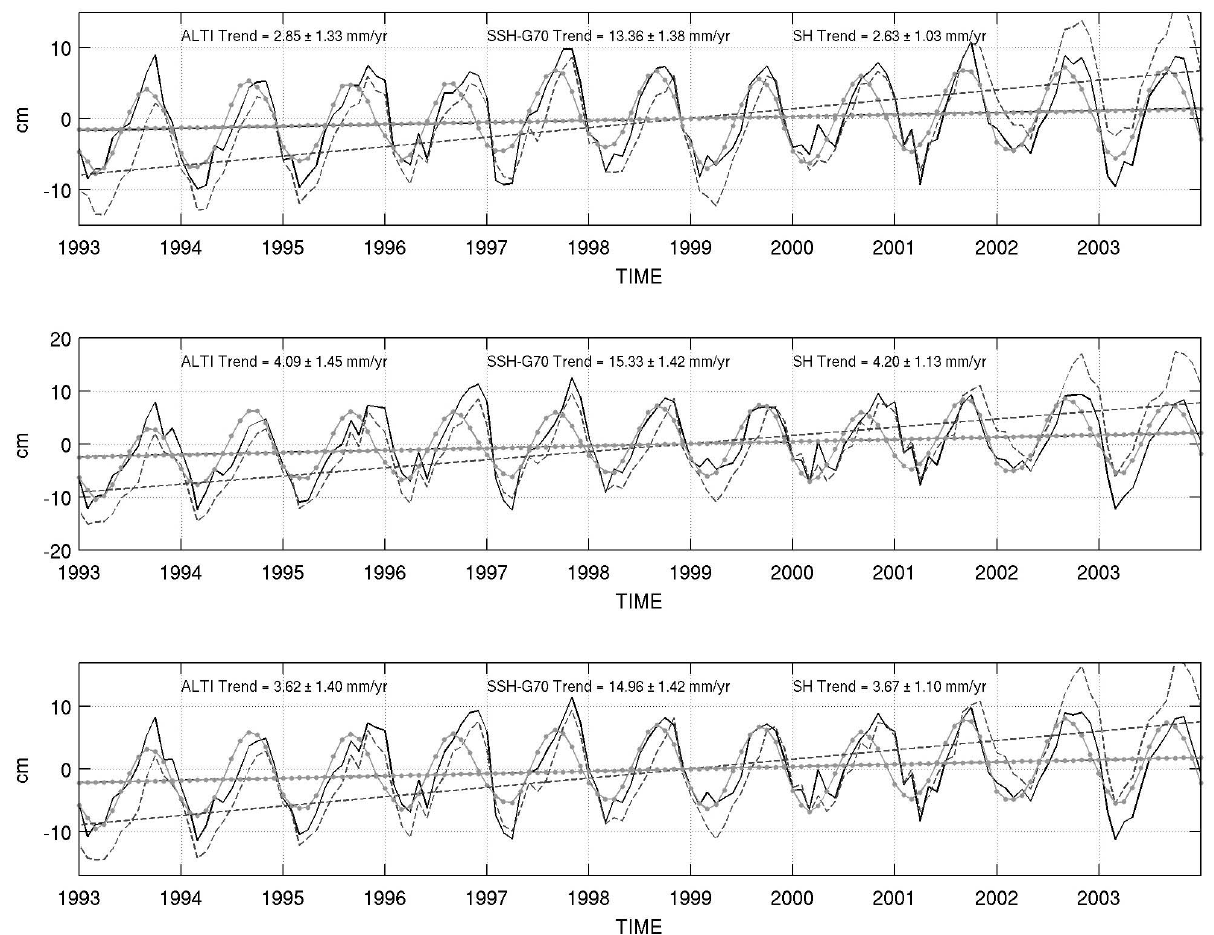
Fig . 5. – Timeseries of ORCA sea surface height (SSH, grey dashed-line), steric height (SH, light-grey line-dot) and altimetry (ALTI, solid black line) for the WMED (top), EMED (middle) and whole Mediterranean